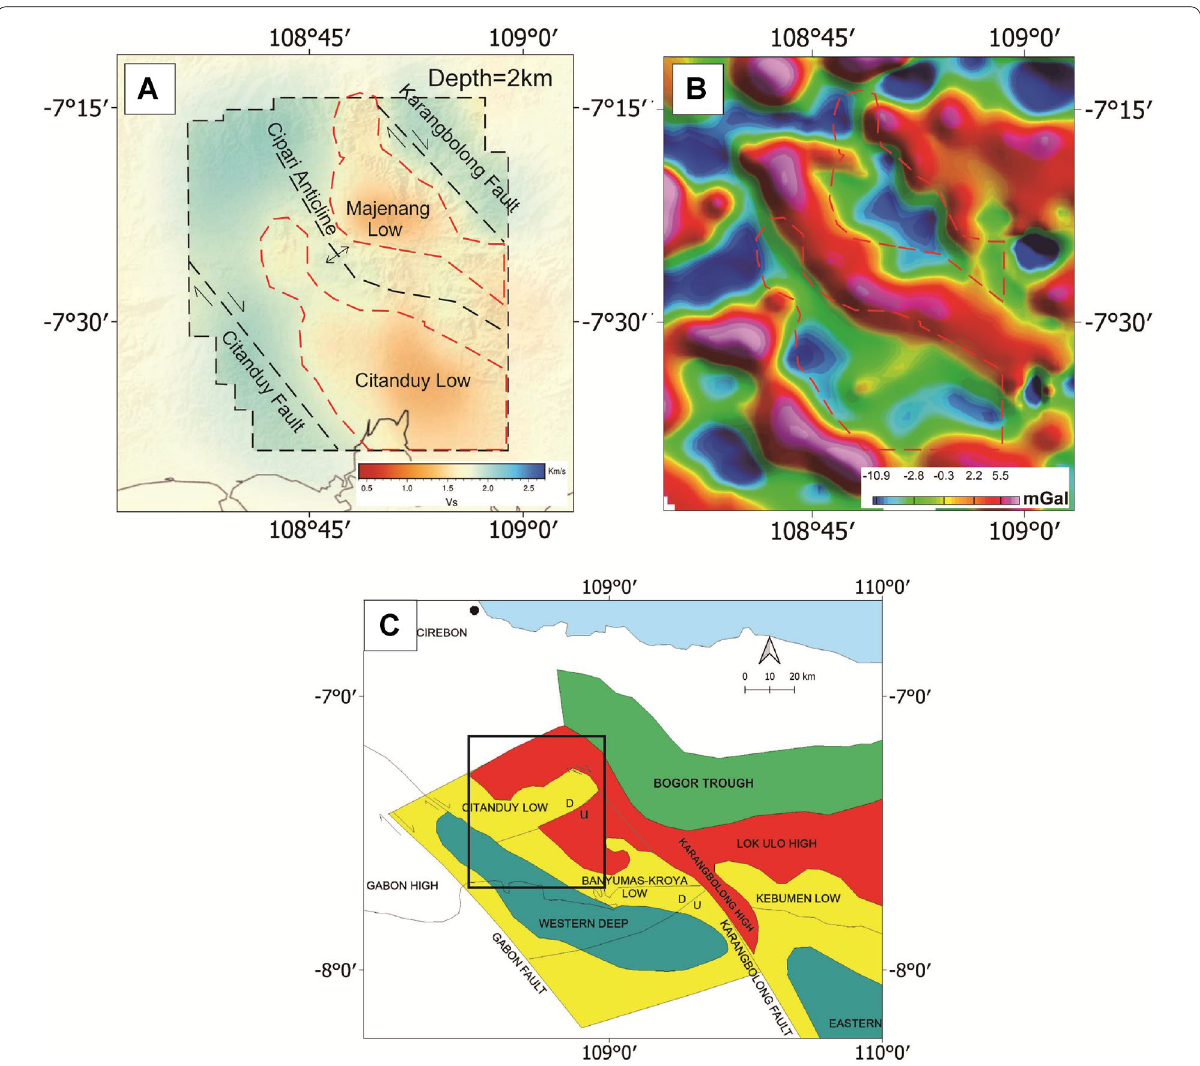
Fig. 8 Comparison of results of the ANT in this study with gravity and geological studies. A Tomogram model of Vs at a depth of 2 km and interpretation of the structure and delineation. The area within the black dashed line represents the resolution limit of the ANT method. The two red dashed line of low Vs indicate the Majenang Low and the Citanduy Low, separated by the Cipari Anticline. The Citanduy Fault located SW and the Karangbolong Fault located NE, according to C ; B the residual Bouguer anomaly map (modified from Hidayat et al. 2020); the red dashed line depicted in A shows low Vs delineation; C configuration of Miocene structure in the southern Central Java (modified from Muchsin et al. 2002). The black square is the study area, utilizing